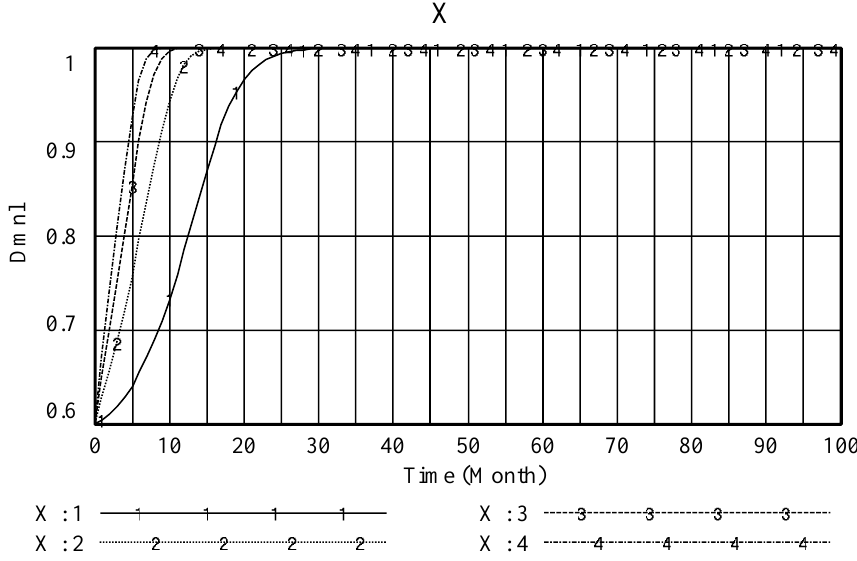
Figure 7. Simulation result of x when the amount of penalty, L changes.